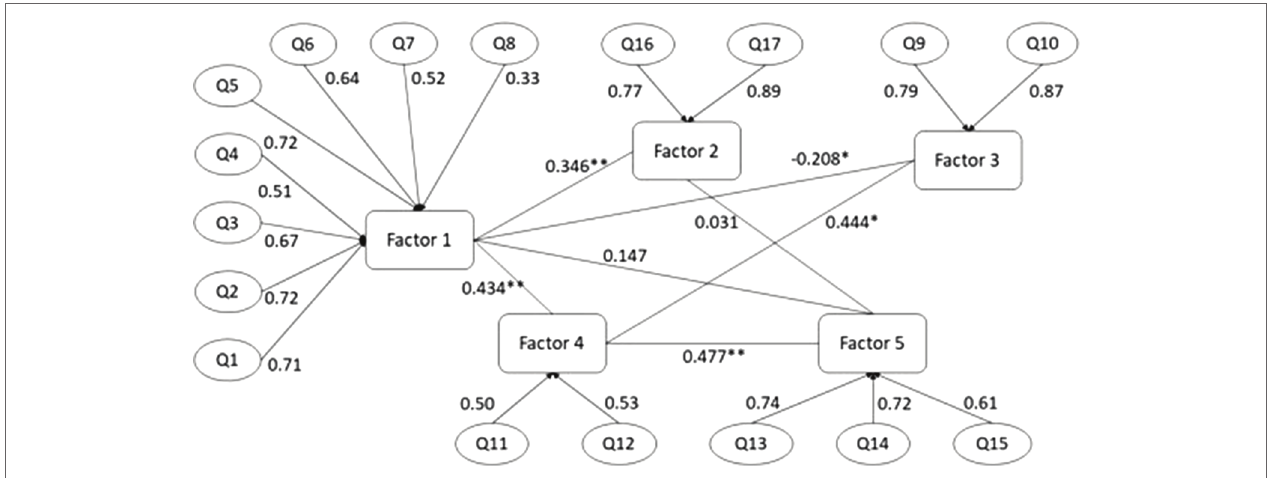
FIGURE 3 | Diagram of the structural equations model (SEM) results for the knowledge and perception questionnaire of pesticide exposure for